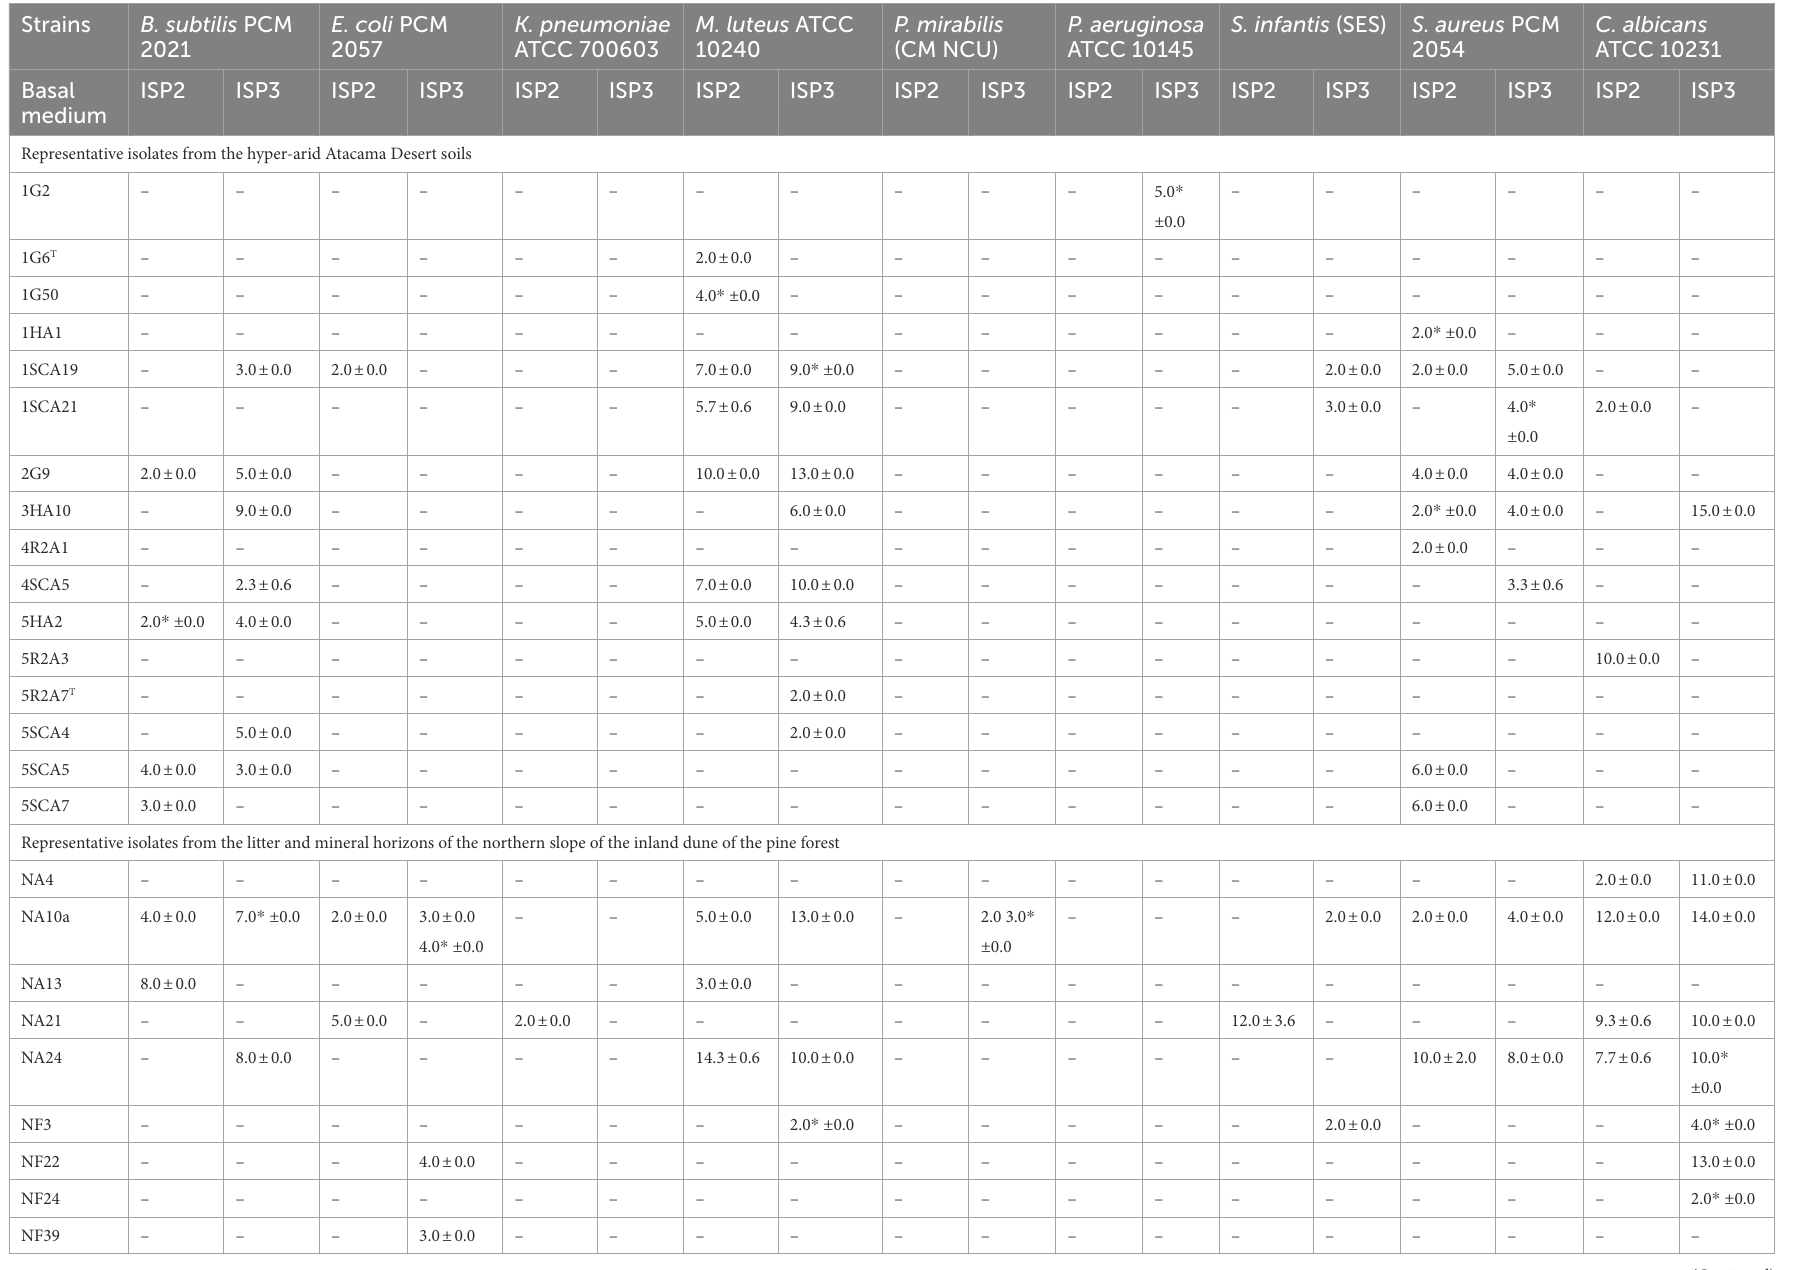
TABLE 2 Antimicrobial activity of representative actinomycetes isolated from the Atacama Desert and pine forest soils using a standard plug assay. Strains